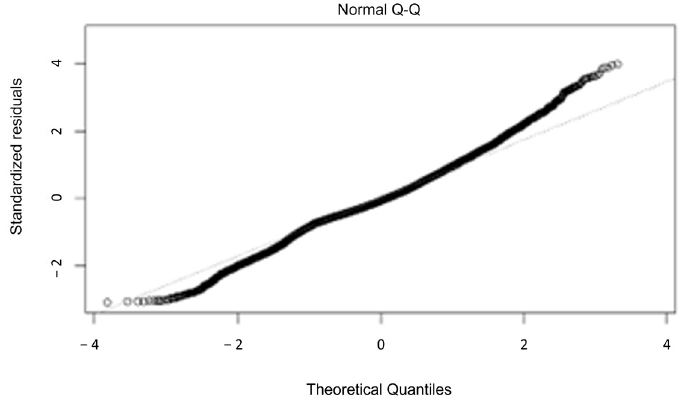
Figure 5. Quantile Plot of the residuals for the ANOVA model. The plot shows the distribution of the residuals of the ANOVA model compared to the normal distribution.